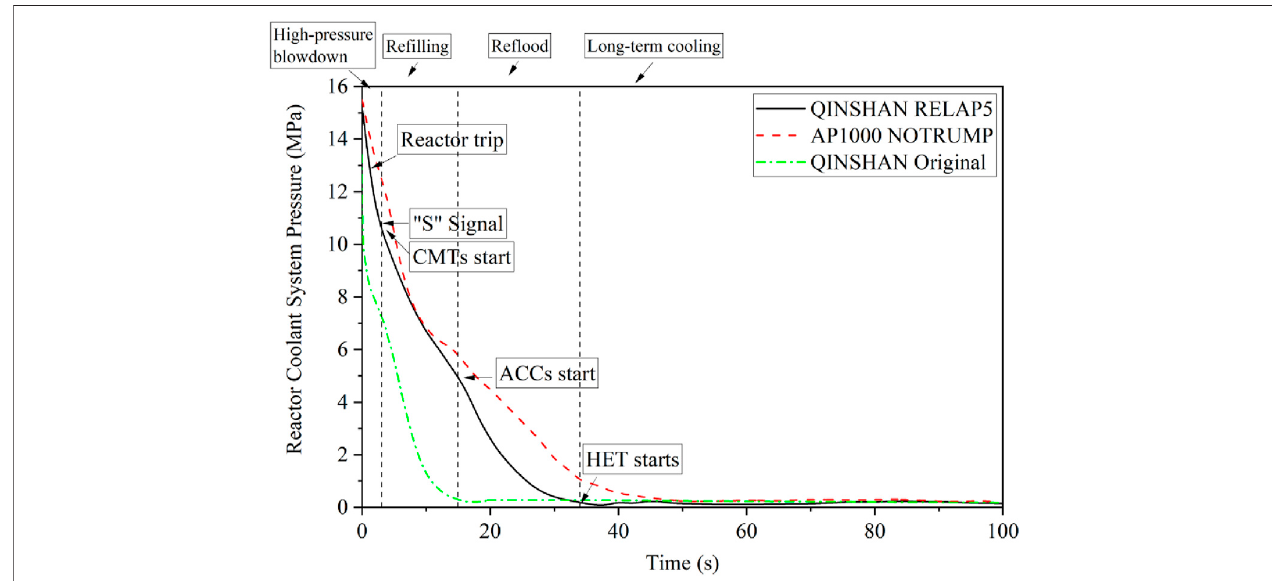
FIGURE 5 | Double-ended CL LBLOCA RCS pressure transient.